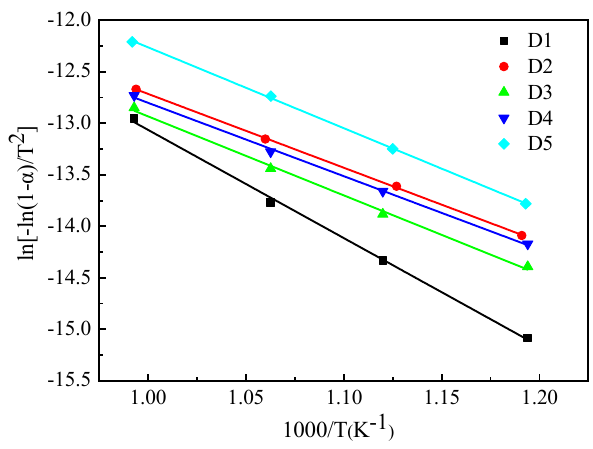
Figure 3: Coats – Redfern method plots of di ff erent samples at 20°C/min.